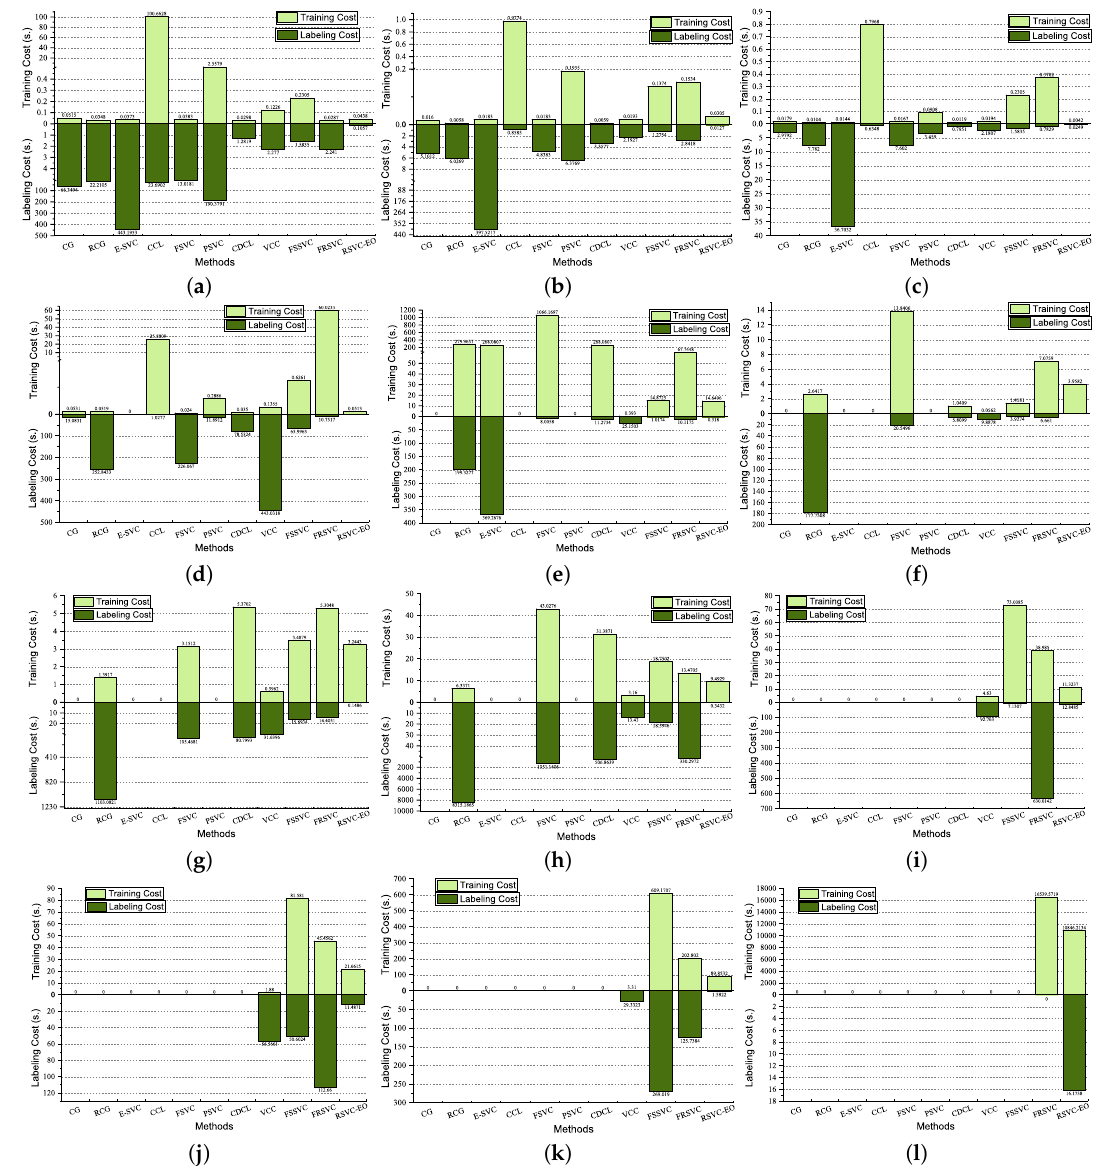
Figure 7. Runtime comparisons of the training phase and labeling phase for the state-of-the-art methods on 12 datasets: ( a ) wisconsin; ( b ) glass; ( c ) wine; ( d ) mLibras; ( e ) P2P-T; ( f ) WebKB; ( g ) abalone; ( h ) Reuters; ( i ) Oh; ( j ) 20NG; ( k ) sh; and ( l )